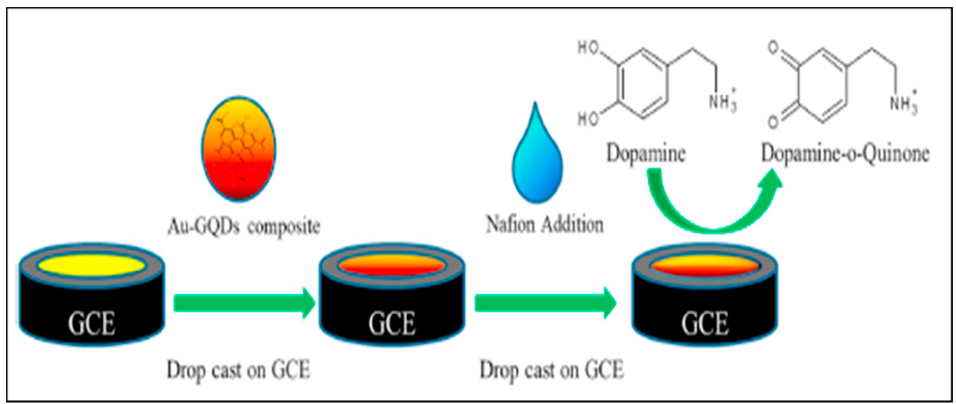
Figure 9. Preparation of the His-GQDs-GMA nanocomposite (Reproduced from [97], copyright Elsevier, 2017). Figure 10. Preparation of Au-GQDS-Nafion-modified electrode for DA detection (Reprinted from [98], copyright Elsevier, 2019).